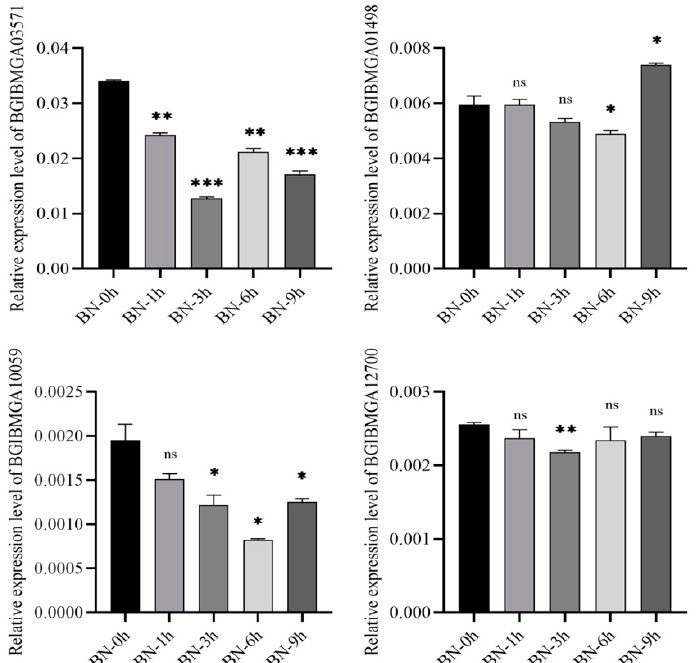
Figure 10. Quantification of identified four DEGs at 1, 3, 6, and 9 h after BmNPV infection in the BN variety by qRT-PCR. Significant differences are indicated by asterisks ( p < 0.05). ns, not significant. *, p < 0.05; **, p < 0.01; ***, p <